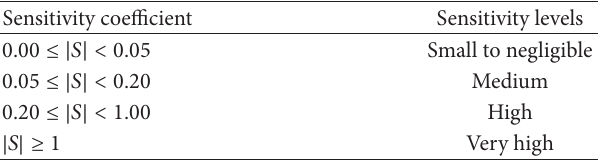
Table 1: Sensitivity levels in the time they are